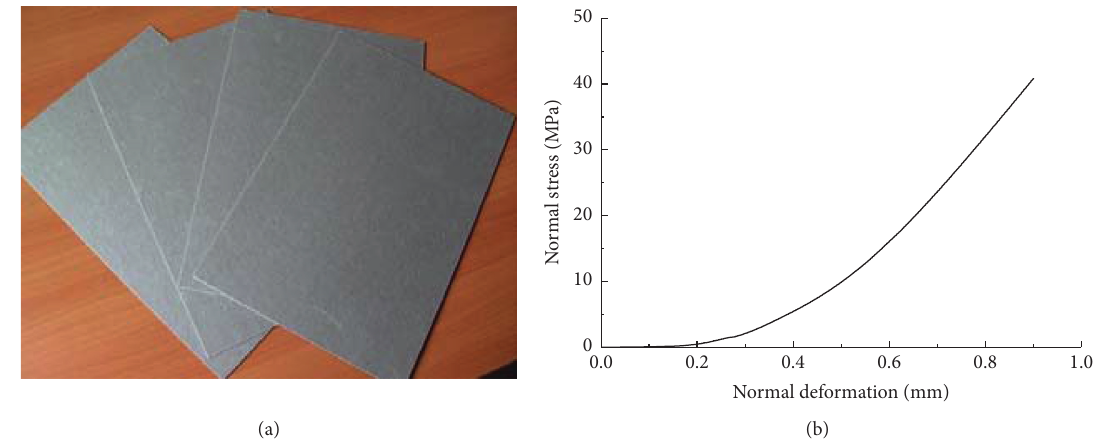
Figure 3: Joint simulation material and its mechanical properties. (a) The mica plates. (b) Normal stress and deformation